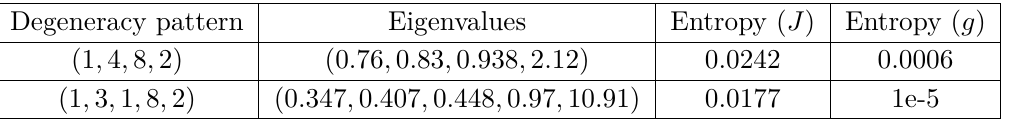
Table 1 . Skaq solutions for su (4) . Each row is a solution ( g, J ) with its degeneracy pattern and eigenvalues for g . For example, in the first solution, the eigenvalue 0 . 76 is the only nondegenerate one. Both solutions have J entropy in-between the 0.5 and 1 percentile of the random baseline